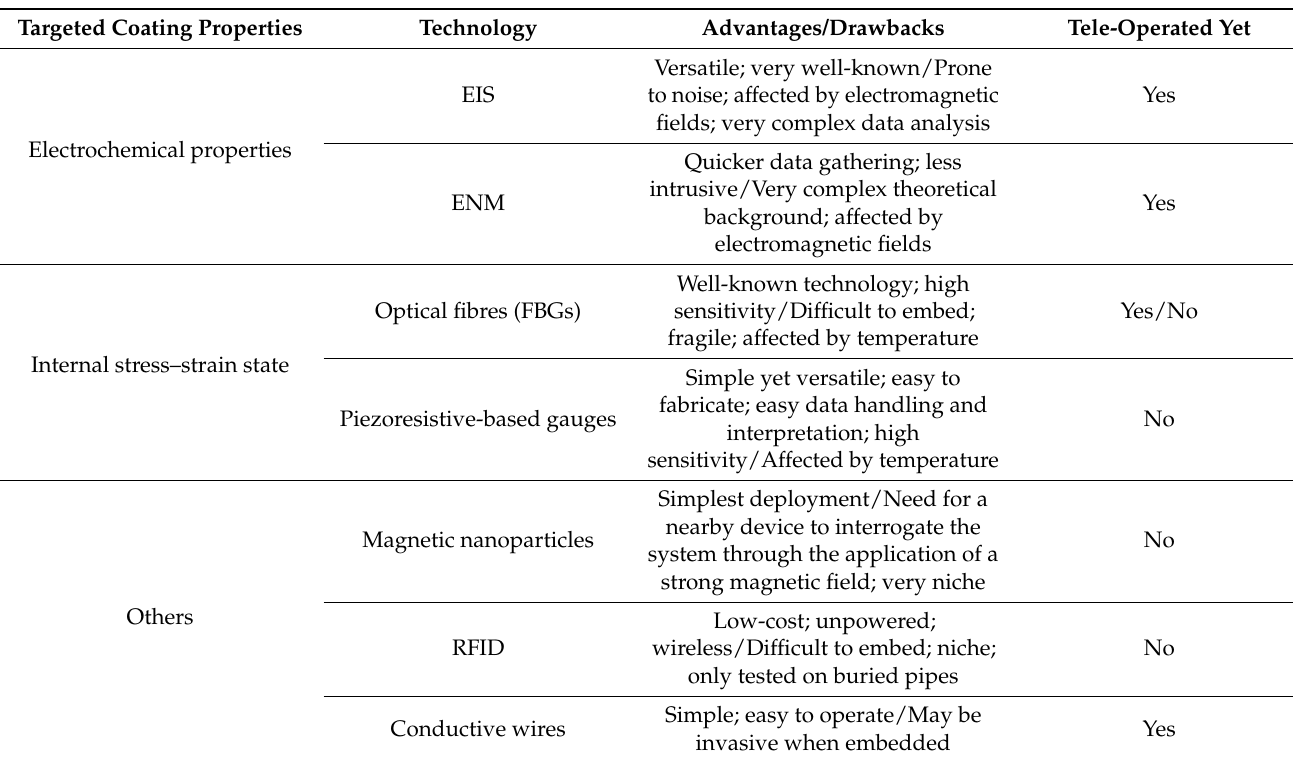
Table 1. The summary table for all of the reviewed embedding techniques for the monitoring of organic